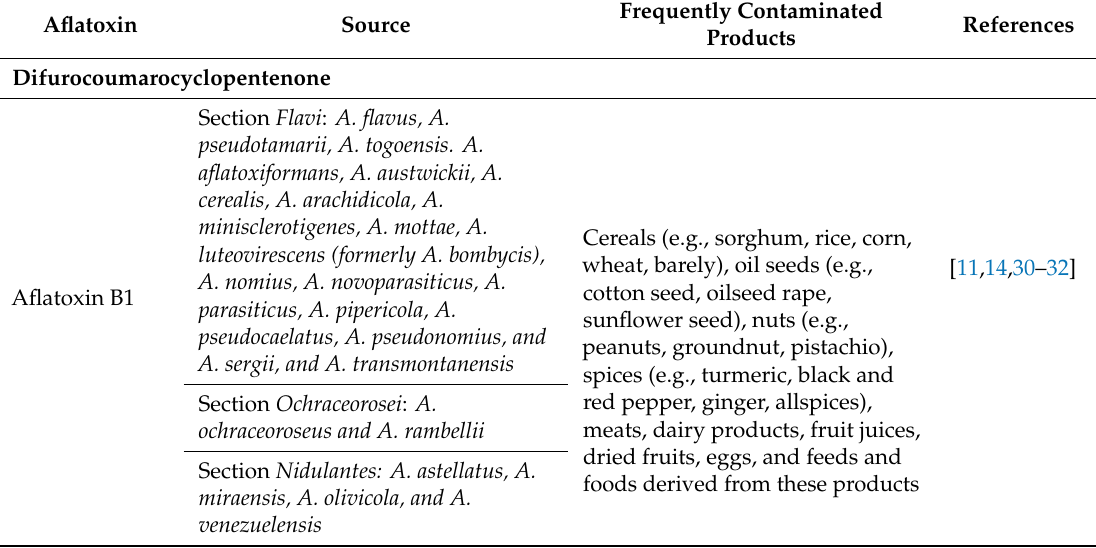
Table 1. Origins of aflatoxins and the products most exposed to